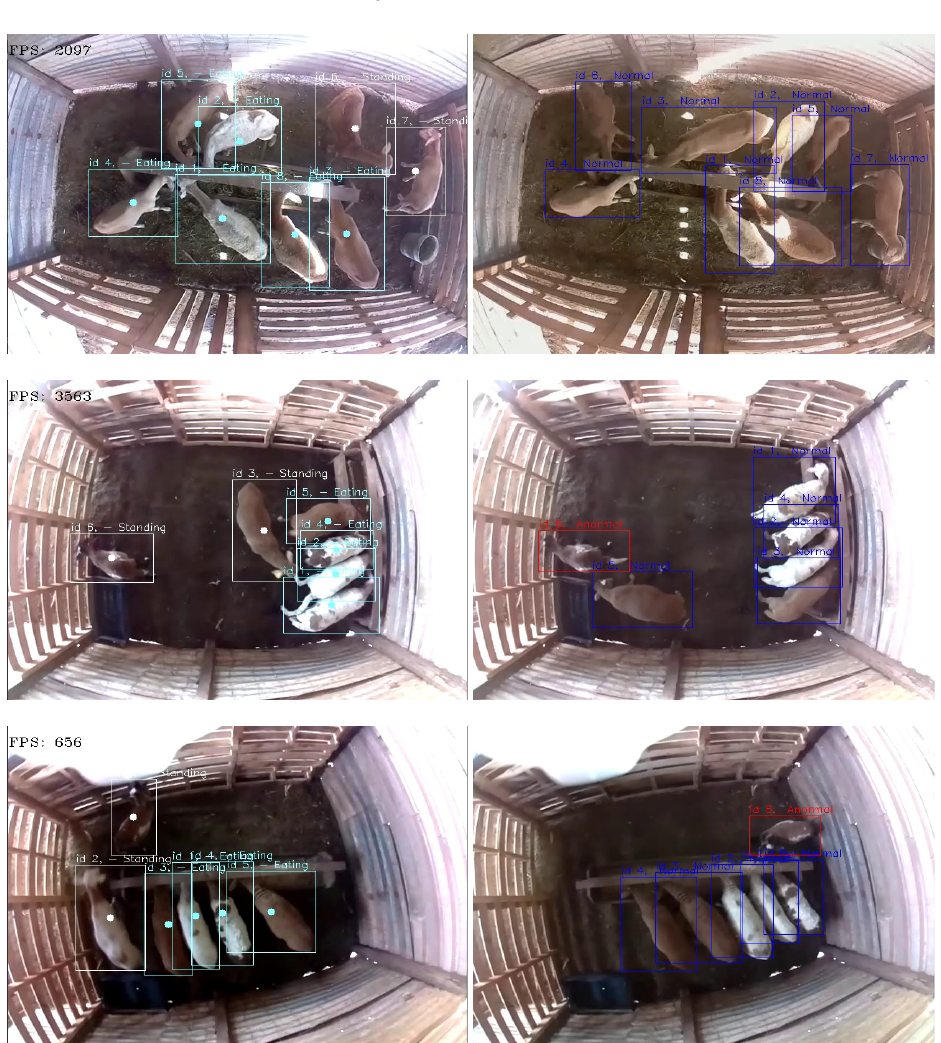
Figure 9. Examples of object detections and the behavior analysis